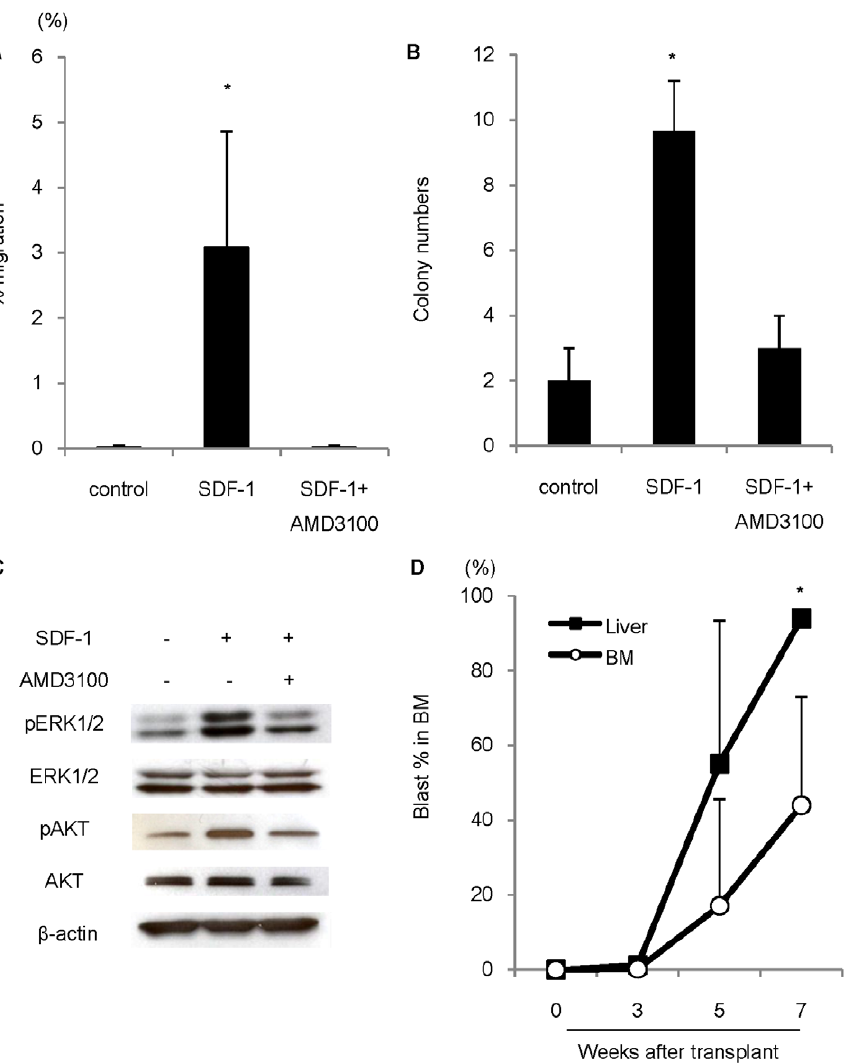
Figure 5. The signaling via SDF-1/CXCR4 axis stimulates migration and proliferation of leukemic cells. (A) Leukemic cells were plated onto upper chamber of transwell plates with 250 ng/ml SDF-1 a in lower chamber, in presence or absence of AMD 3100 pretreatment. Results expressed as percentage of migrating cells to input cell number. (* P =0.014, Student’s t- test, n =4). (B) Methylcellulose colony-forming assay to evaluate effect of SDF-1/CXCR4 signaling on leukemic cell proliferation. Addition of SDF-1 a significantly increased leukemic colony numbers, and treatment with AMD3100 counteracted effect of SDF-1 a (* P =0.0019, Student’s t- test, n =3). (C) Phosphorylation of ERK1/2 (pERK1/2) and Akt (pAkt) was detected by Western blot analysis. b -actin was used as a loading control. (D) Sequential FACS analyses showing bone marrow engraftment after transplantation of leukemic cells harvested from BM and liver of ALL leukemic cell-transplanted mice. Graphs show percentage of blast cells in recipient BM (* P =0.0048, Student’s t - test, n =4 2 8 mice per case). Data are shown as means 6